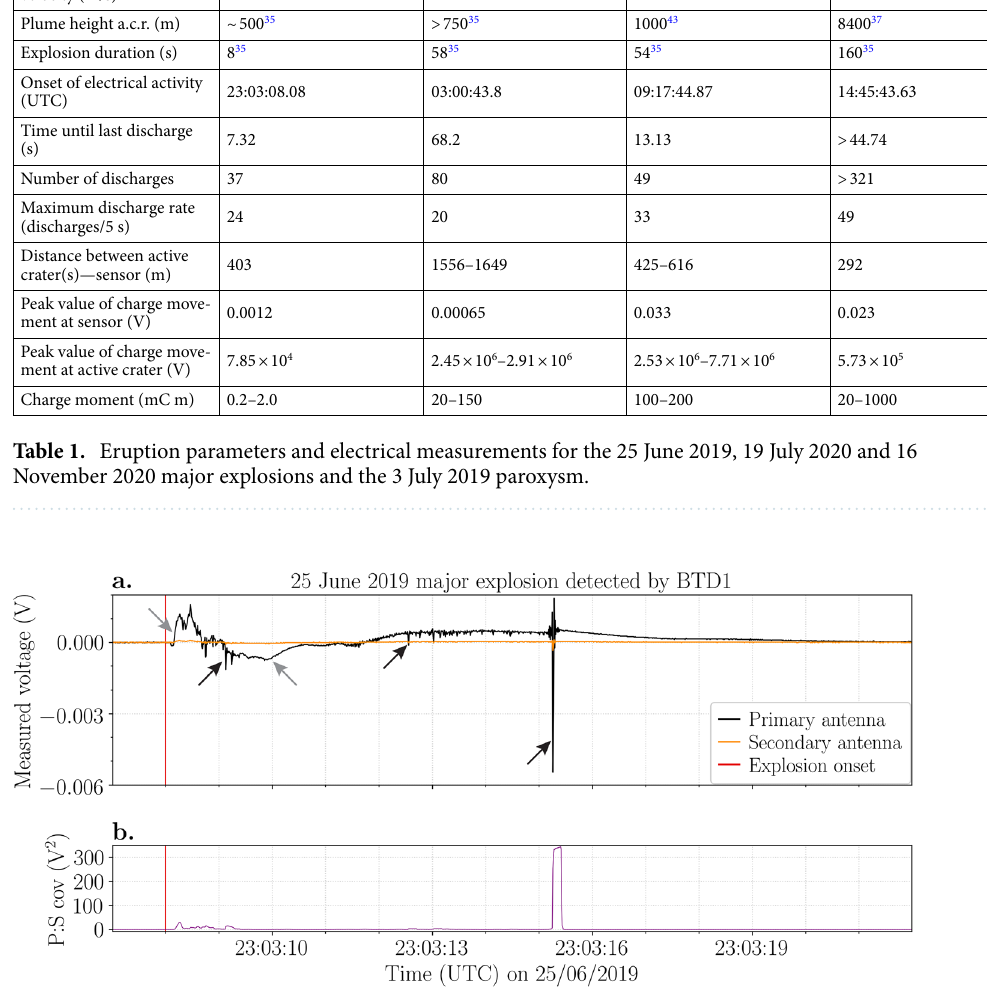
Figure 2. Electrical data of the 25 June 2019 major explosion recorded by BTD1. ( a ) Voltage (V) measured by the primary (black line) and secondary (orange line) antennas. Examples of movement of charge and electrical discharges are indicated by the grey and black arrows, respectively. ( b ) The covariance (V 2 ) between the primary and secondary signals. The red vertical line indicates the explosion